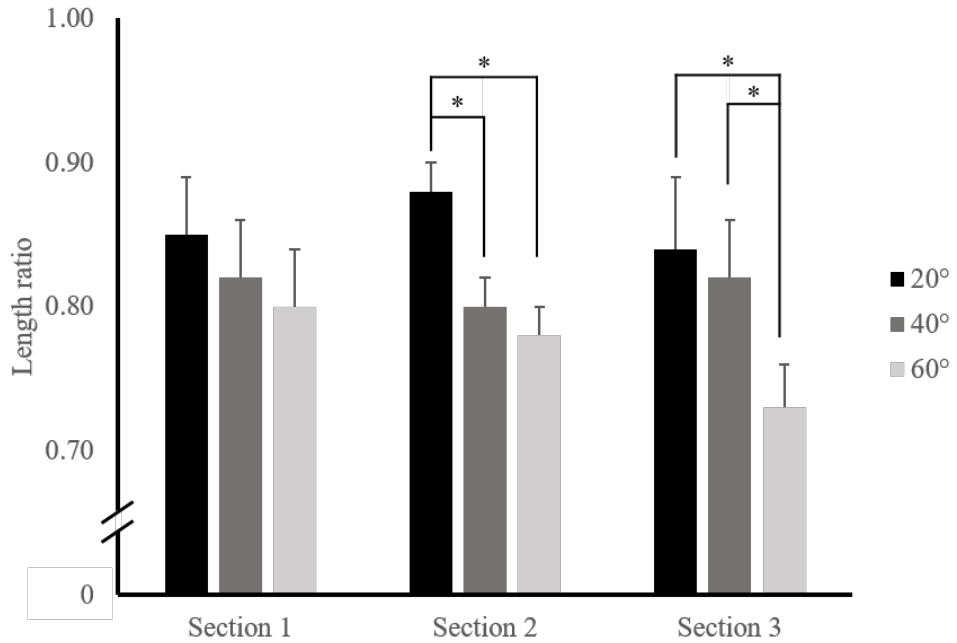
Figure 5. Group mean ratio of length changes by each curl-up angle in each section (the error bars indicate the standard error). Note that all curl-up angles showed significant differences in each section when compared to the rest position. * p < 0.05 .